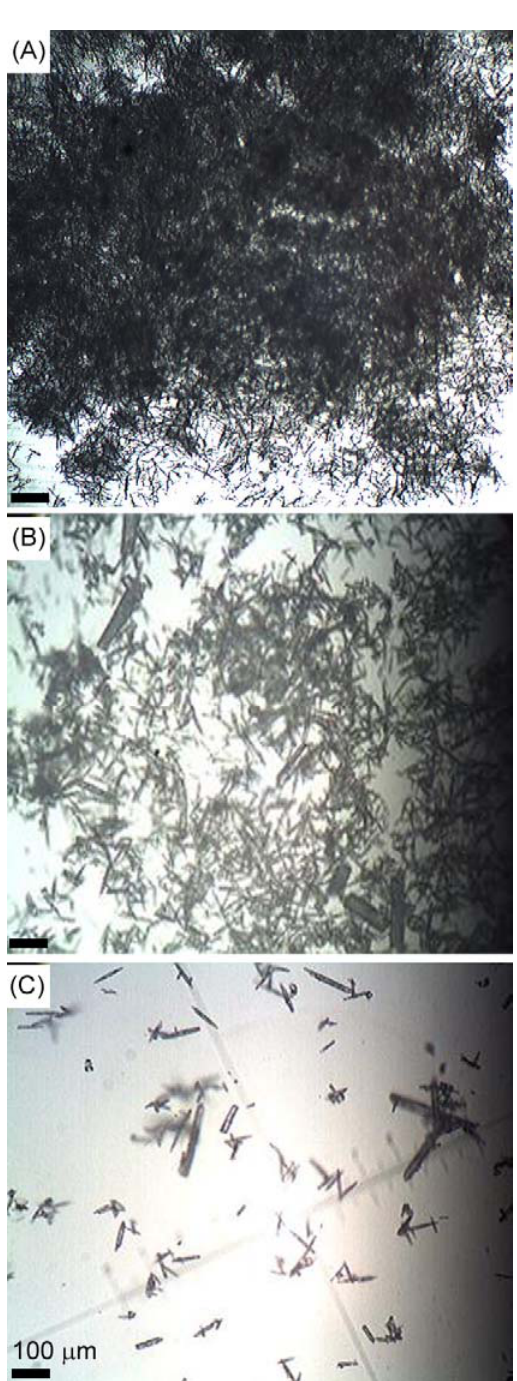
Figure 3. Optical microscopy images of the aragonite whiskers produced with different concentrations of starting materials ( A ) 1.44 mol ⋅ L − 1 CaCl ( C ) 0.06 mol ⋅ L − 1 CaCl 2